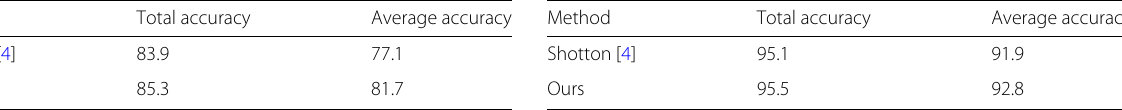
Fig. 5 Annotations of TUD. a The initial image, b the groundtruth labeling of categories, c the groundtruth labeling of instances, and d the bounding boxes of instances. Best viewed in color higher than T p and the saliency value of i is higher than T s as well, The weight on node i consists of the probability, the saliency and the bounding box score. Otherwise, the weight on node i consists of the probability of other cate- gory and the negation value of saliency, as shown in Eq. 3.